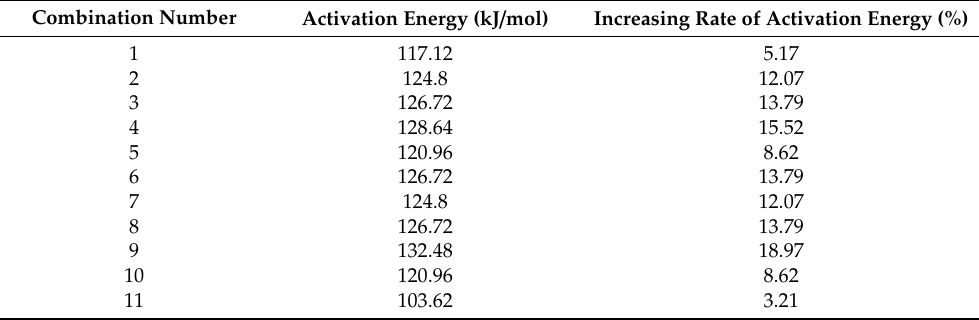
Table 5. Activation energy and its increasing rate of the